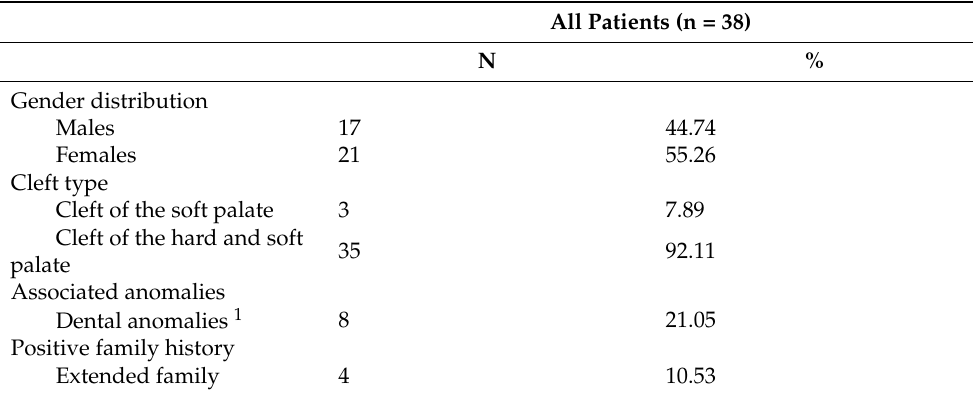
Table 1. Characteristics of the patient